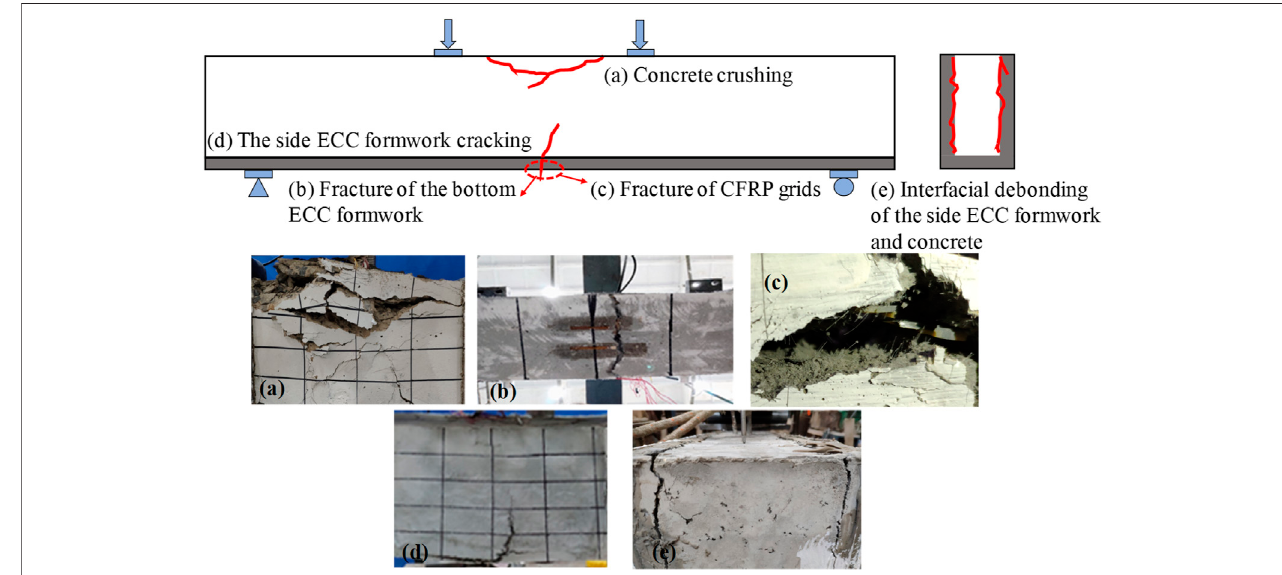
FIGURE 4 | Typical failure modes of the tested